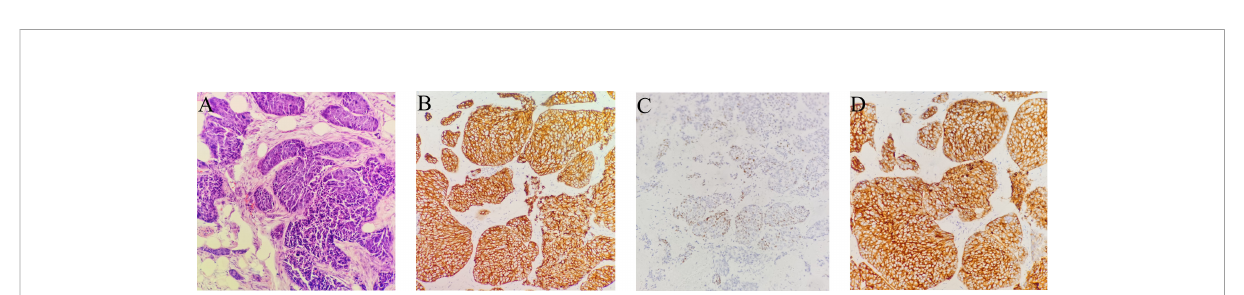
FIGURE 2 Biopsy of subcutaneous soft tissue metastasis in the left upper quadrant of the abdomen. (A – D) . (A) Squamous cell carcinoma is observed, which in fi ltrates the adipose tissue. Atypical epithelioid cells are observed in fi bro tissue, muscle tissue and adipose tissue. (hematoxylin and eosin, original magni fi cation × 200). (B) Positive CK5/6 immunohistochemical staining in a membranous distribution on the tumor cells (brown) (hematoxylin and eosin, original magni fi cation × 200). (C) Positive P40 immunohistochemical staining (brown) (hematoxylin and eosin,